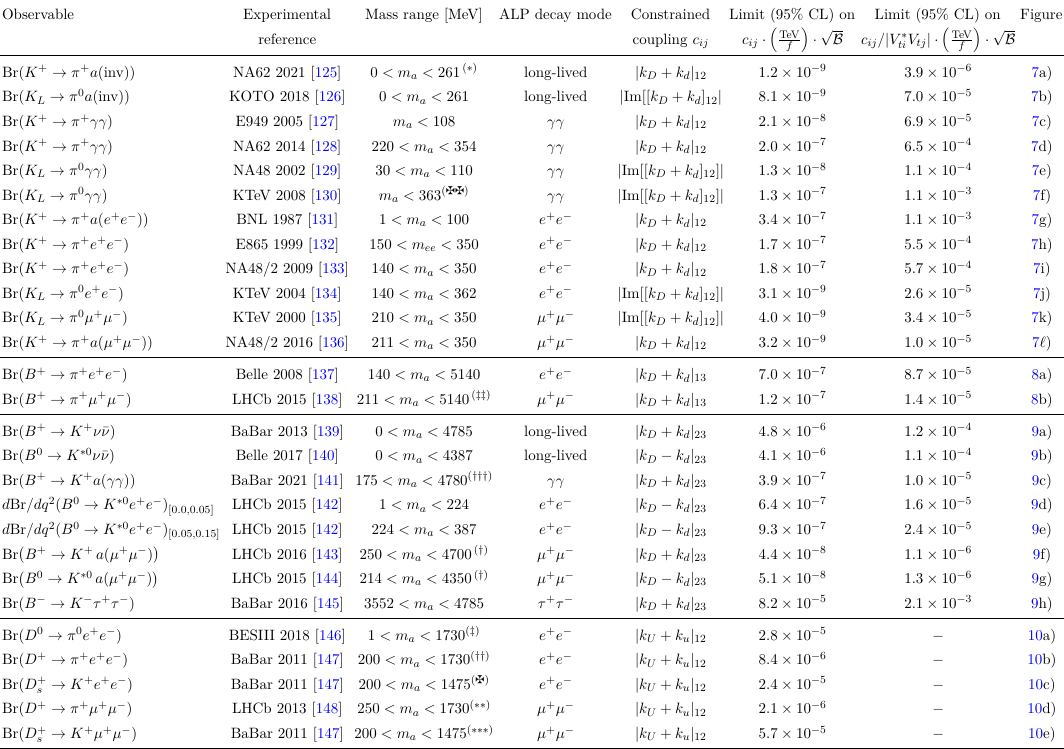
Table 1 . Summary of indicative constraints on quark flavor-violating ALP couplings renormalized at the scale µ = m , derived from measurements of branching fractions (first column) for various w t decays of kaons and B mesons in a mass range where an on-shell ALP can be produced. The experimental reference is given in the second column, while full details of the measurements and